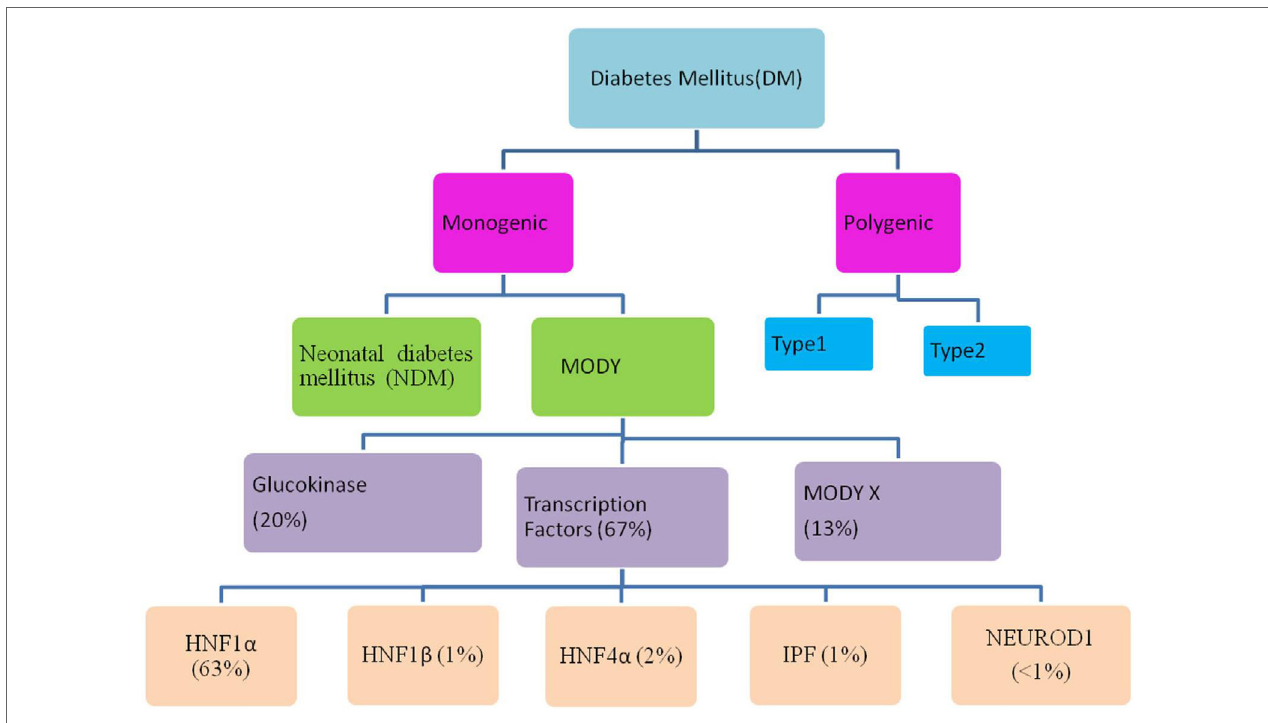
FiGURe 1 | Flow through diagram showing types of diabetes mellitus including the relative prevalence of various maturity-onset diabetes of the young (MODY) causing